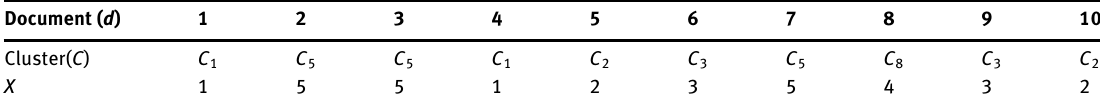
Table 1: An Example of a Solution Representation of the TCP-GWO. Document ( d